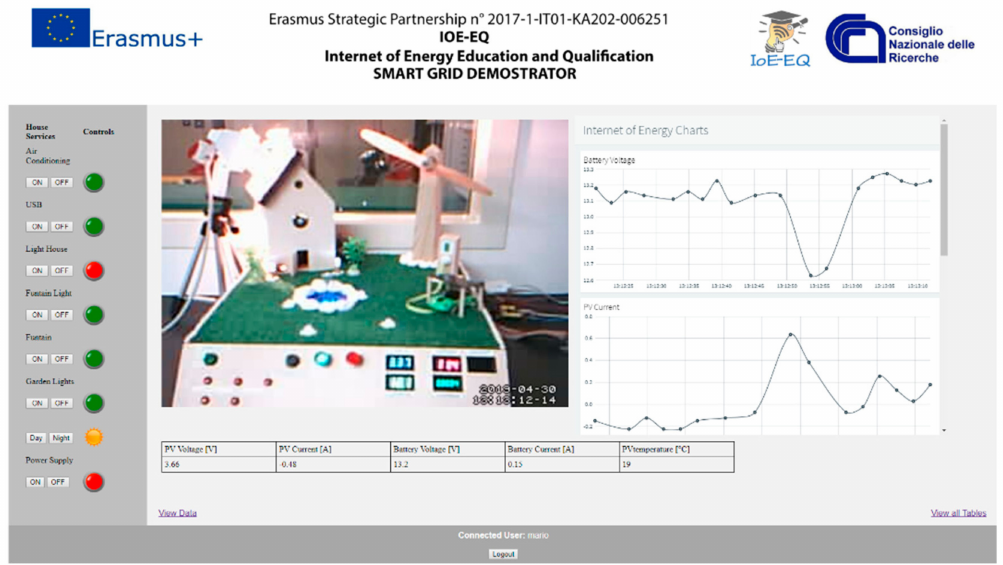
Figure 5. Picture of the software